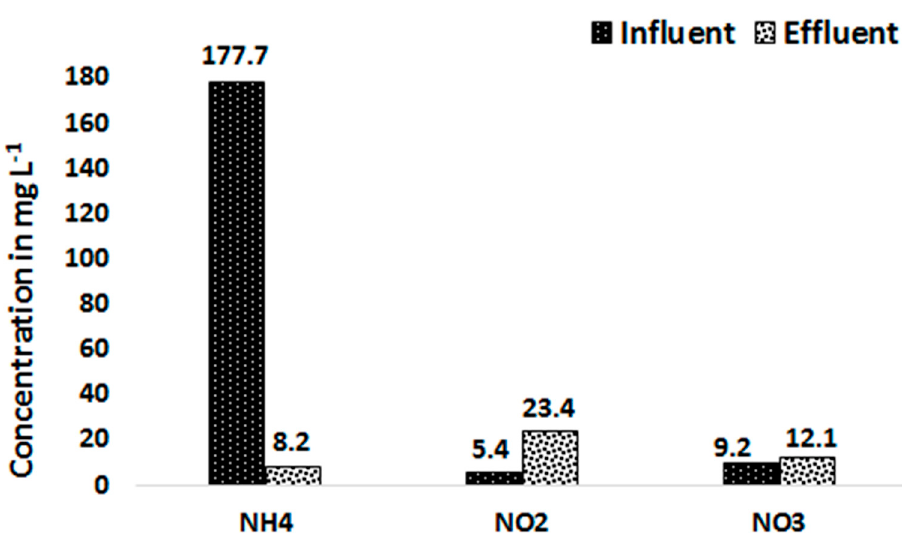
Figure 9. Average influent and effluent concentrations of NH 4 -N, NO 2 -N and NO 3 -N.